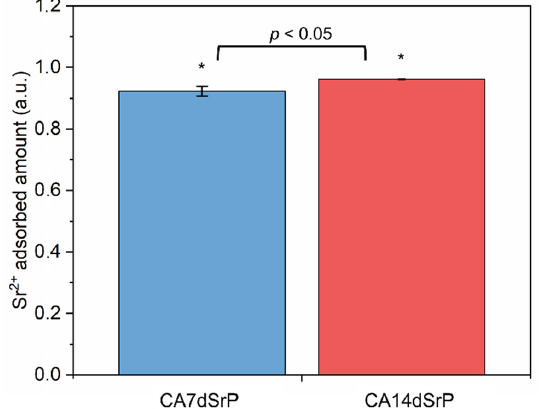
Figure 6. Relative Sr 2+ adsorption of CA in m-SBF solution after 7 and 14 days for